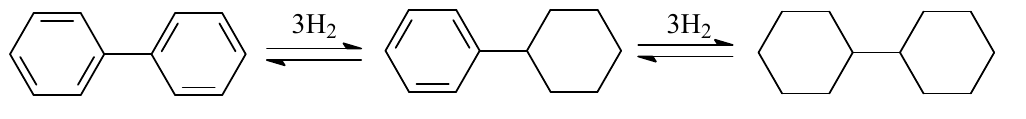
Figure 9. Biphenyl as liquid organic hydrogen